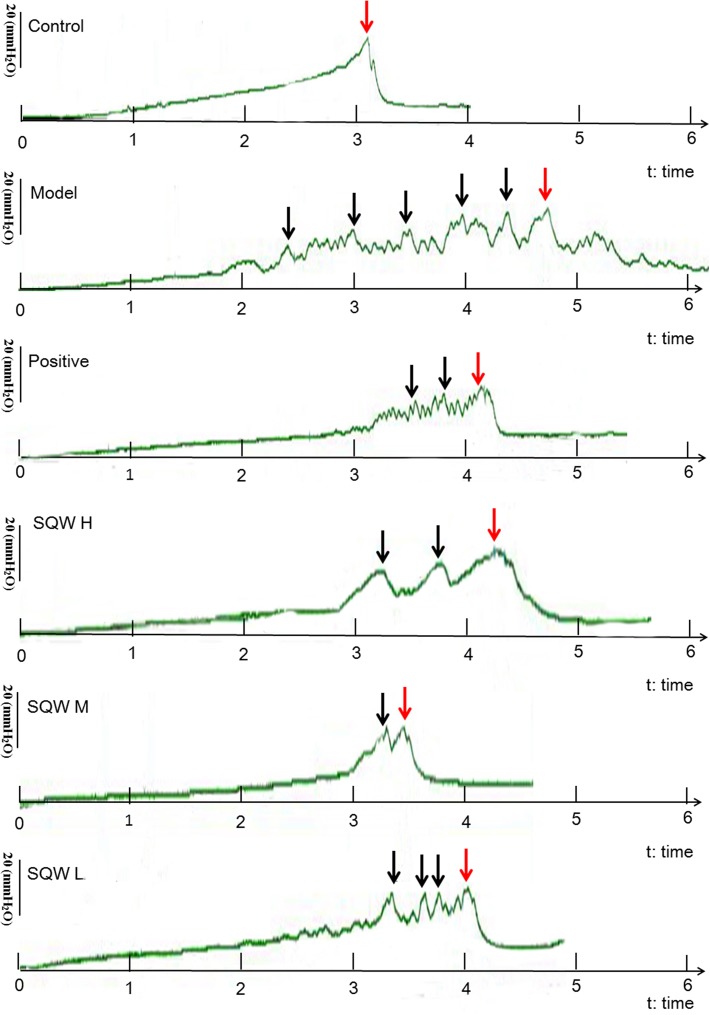
Representative urodynamic test recording from the six groups of mice. Red arrows indicate the micturition peaks, and black arrows represent the NVC frequency.